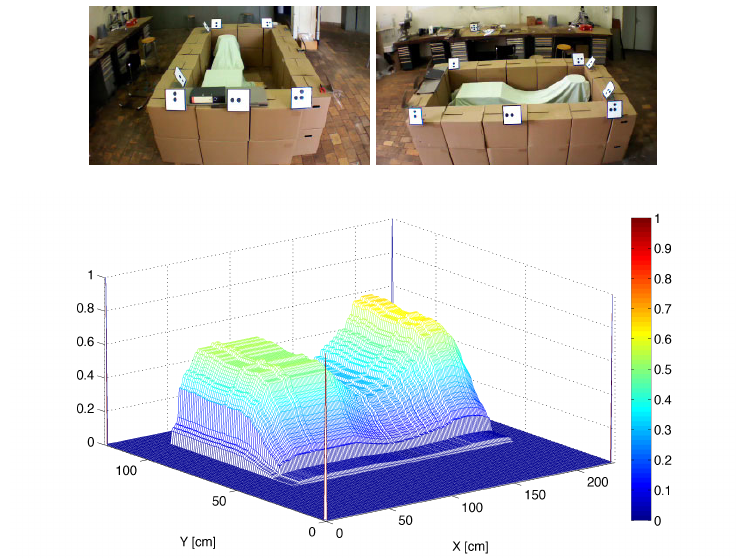
Figure 15. 3D profile obtained experimentally using the smart flying sensor and two